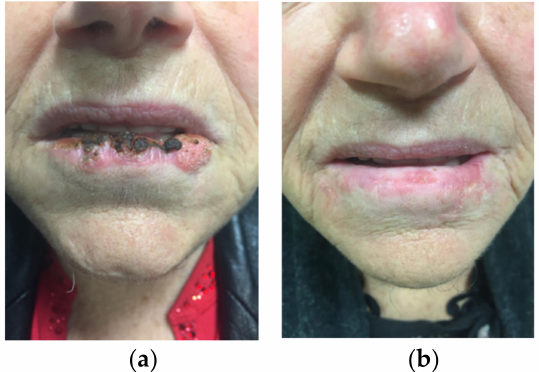
Figure 4. ( a ) Inferior lip cancer before treatment; ( b ) inferior lip cancer 1 year after